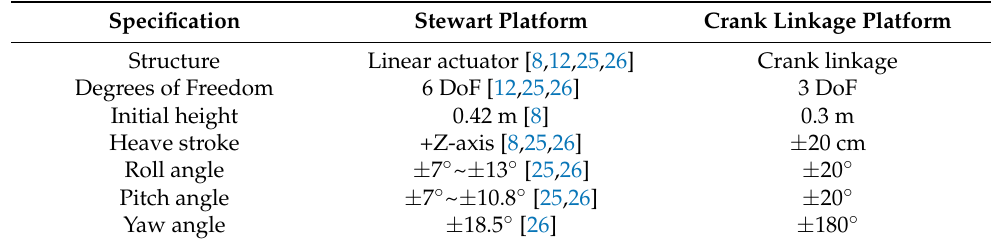
Table 3. The comparison with Stewart platform.